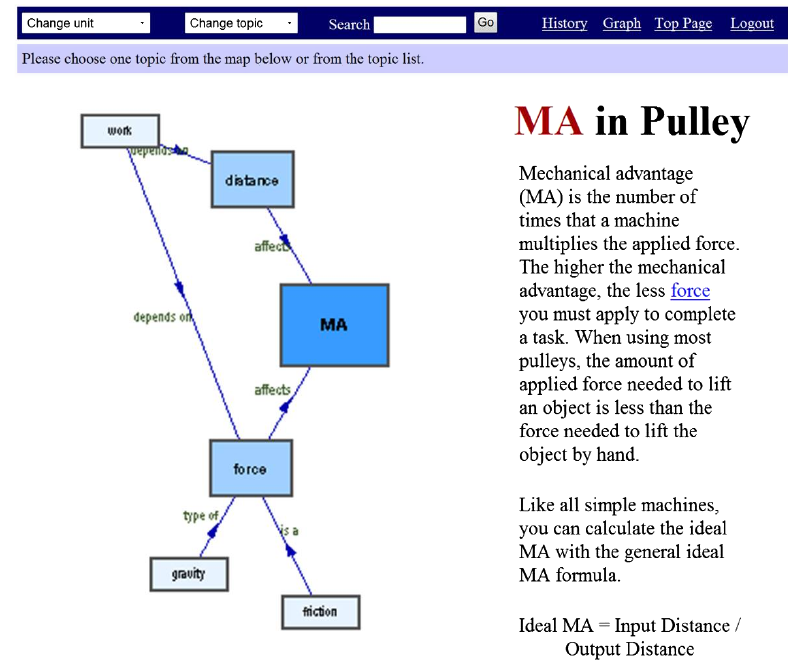
FIG. 1 (color online). The CoMPASS hypertext system. Students used the system to explore the physics concepts related to